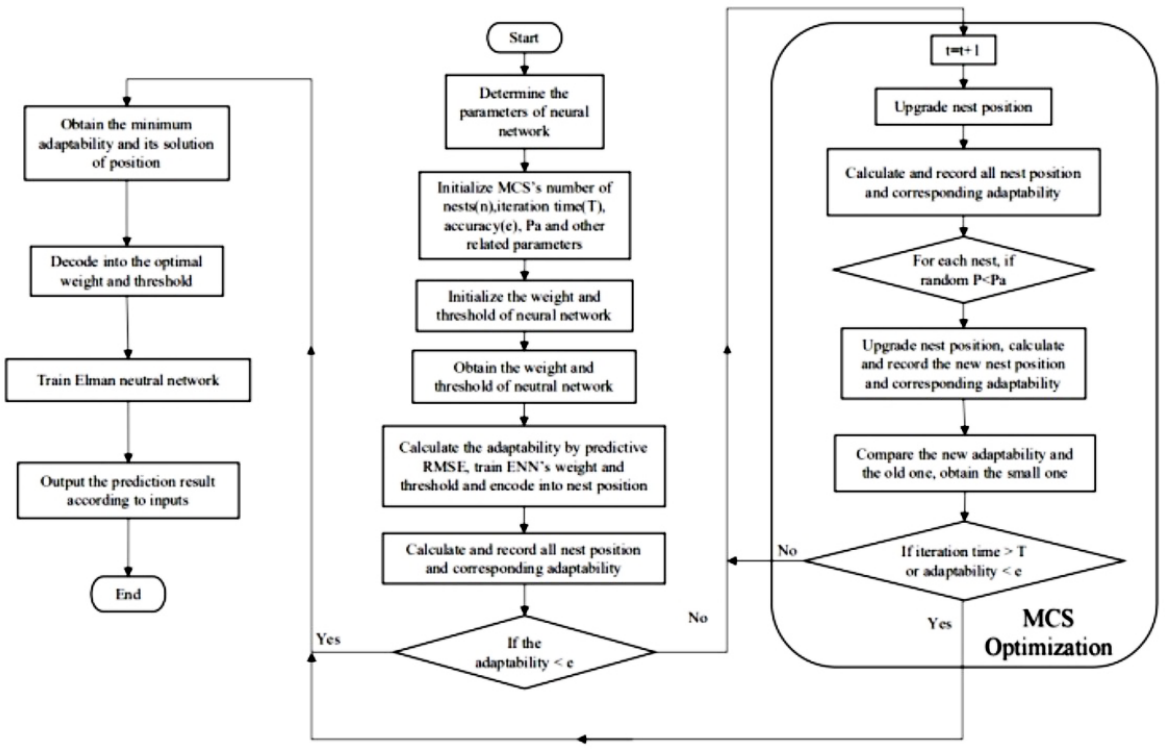
Figure 6. A flowchart of the MCS-Elman neural